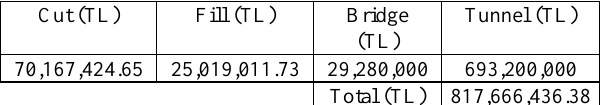
Table 14. Volume of earthworks required for the construction of